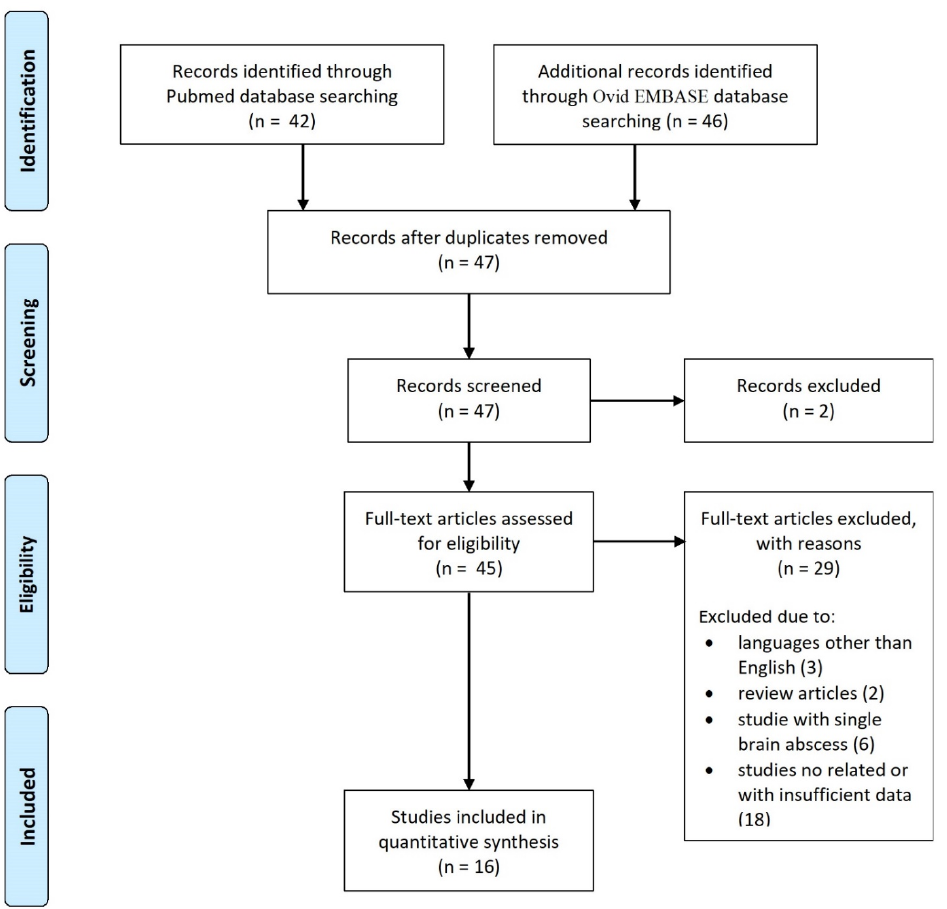
Figure 1. PRISMA flow diagram.